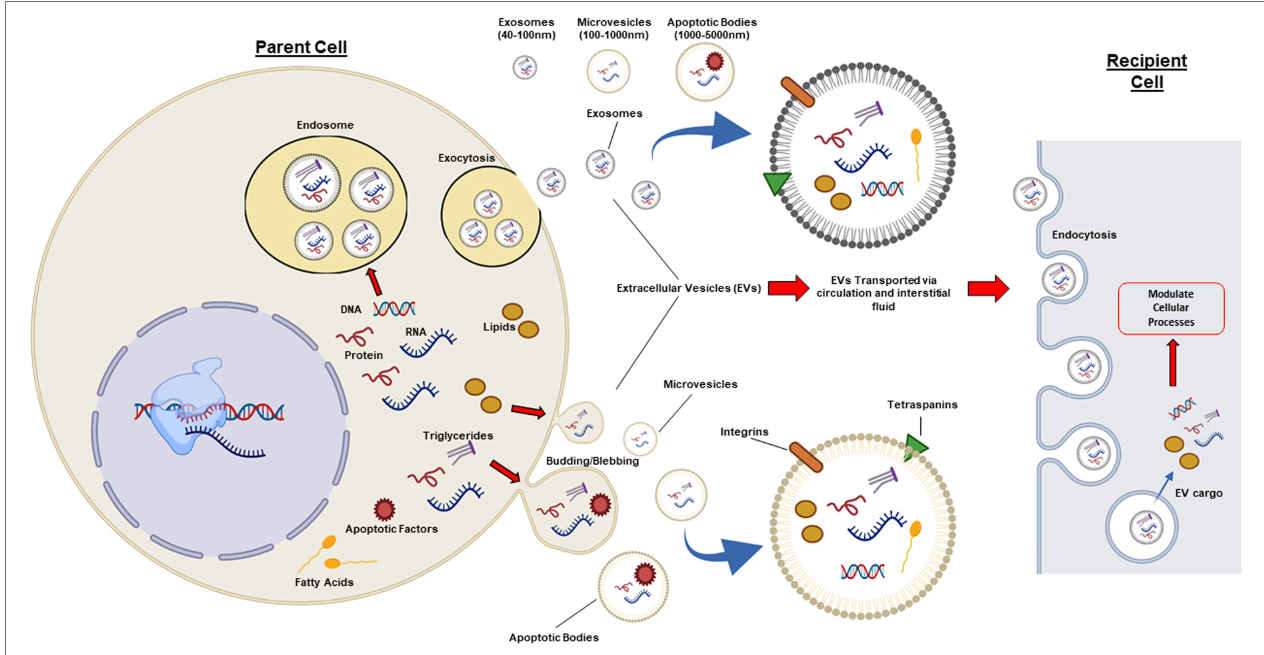
FIGURE 1 | Cellular pathways involved in extracellular vesicle biogenesis. Extracellular vesicles (EVs) are a heterogeneous population of lipid bound vesicles that are released by the majority of mammalian cell types into the extracellular space and circulation. EVs consist of three main subtypes: exosomes (40–100 nm); microvesicles (100–1,000 nm); and apoptotic bodies (1,000–5,000 nm), which differ in their size, content, biogenesis, and release. Exosomes are generated and released via a pathway involving exocytosis, whereas microvesicles and apoptotic bodies are released via a budding/blebbing pathway. EV cargo includes nucleic acids, proteins, and lipids, which are highly regulated by the health status of the parent cell. Once in the extracellular space or circulation, EVs can target adjacent cells and peripheral tissues. EVs have common surface markers (tetraspanins: CD63, CD9, CD81, and CD82) and can have specific surface markers for cell targeting, such as integrins. EVs can elicit effects in recipient cells via cell receptor interactions or via absorption and release of biological cargo into the cytoplasm of the recipient cell. Figure created with